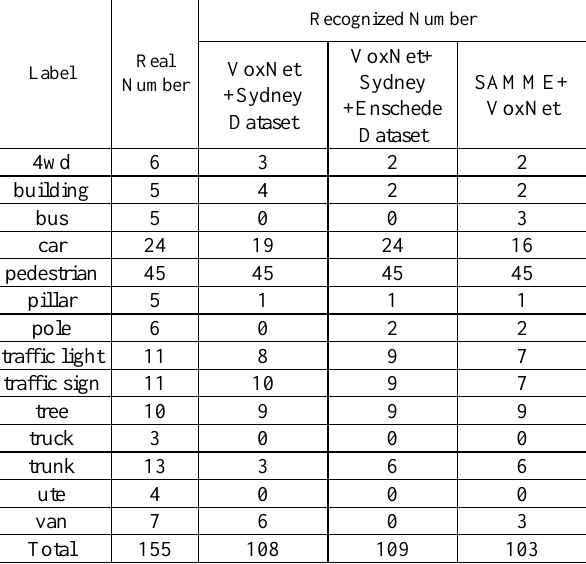
Table 2. The comparison of correctly recognized objects in each class from three experiments. D1 represents the Sydney dataset, and D2 represents the Enschede